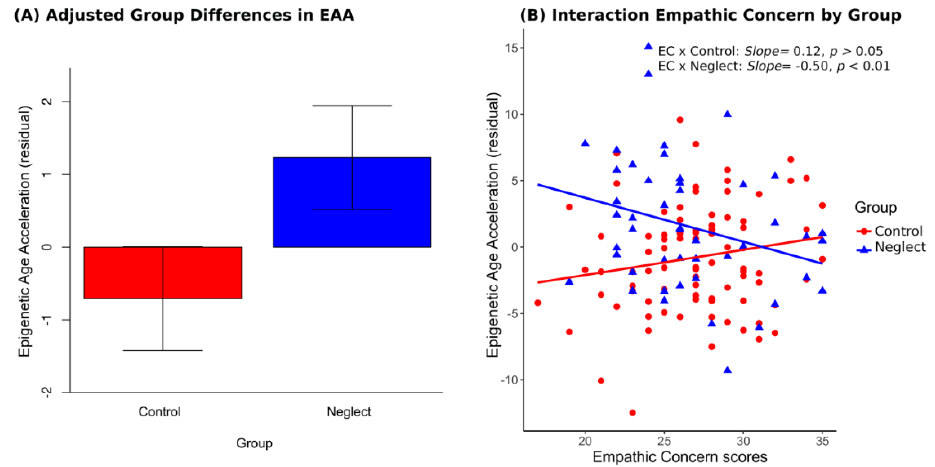
Figure 2. ( A ) Comparison of means showing higher epigenetic age acceleration (EAA) in NG compared to CG, once ad- justed by empathic concern, educational level, family type and having discarded the contribution of maternal age, number of pregnancies, financial assistance, intensity of adverse events, childhood maltreatment and psychiatric disorders. ( B ) Empathic Concern interaction showed negative relationships with epigenetic age acceleration in NG only. An increase in empathic concern was associated with decreased epigenetic age acceleration for mothers in the neglect group (NG). For visual clarity, slopes for empathic concern were plotted from independent estimations and not from partial betas or ad- justed by the rest of the variables.